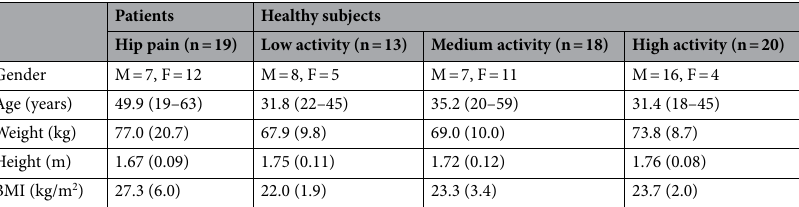
Table 1. Characteristics of the healthy subjects and patients groups. The age values correspond to mean (min– max) values, while mean (standard deviation) values are reported for the other